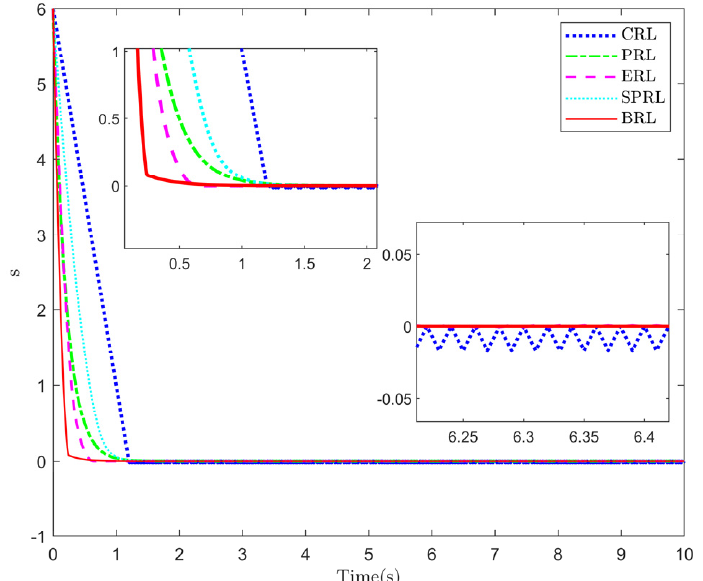
Figure 2. Simulation of different reaching laws. SMC is a type of variable structure control (VSC). In the control application of VSC, the state response of the system can be divided into three stages, namely reaching mode (RM), sliding mode (SM), and steady-state mode (SS). In practical applications, the switching of the VSC system rarely occurs on the switching plane. Therefore, the switching plane of the VSC system is called an ideal switching plane. For second-order systems, there are generally two acceptable sliding-mode state trajectories. Trajectories of type-I are ideal trajectories and type-II are trajectories with bandwidths. In this paper, a new control strategy is designed based on the type-I trajectory. In order to satisfy the two conditions of the type-I trajectory, the state is required to reach the switching plane at the switching time, and the natural dynamics of the object coincide with the ideal switching plane. A new reaching law is designed for the former condition, and for the latter, ESO is used to compensate the multi-channel’s uncertainty in the system in time. Reference [35] focuses on second-order non-linear discrete systems with matched disturbances. On the basis of the former, the control method proposed in this study has expanded applicability and can be applied to systems with mismatching